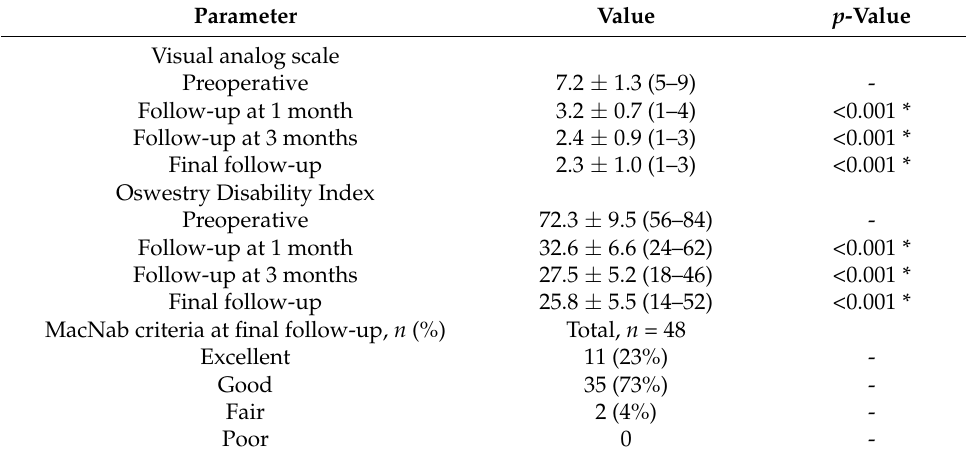
Table 3. Clinical